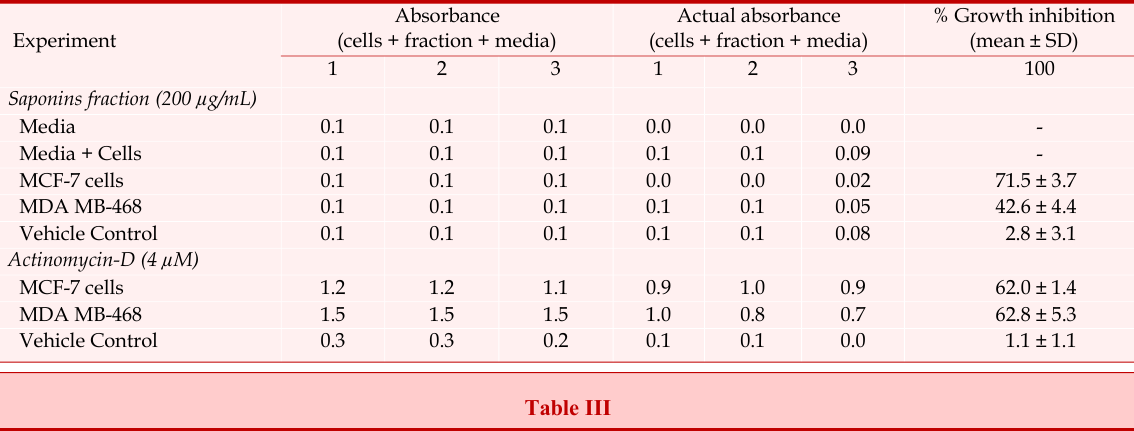
Cytotoxic activity of saponins fractions from Gaultheria trichophylla using NRU